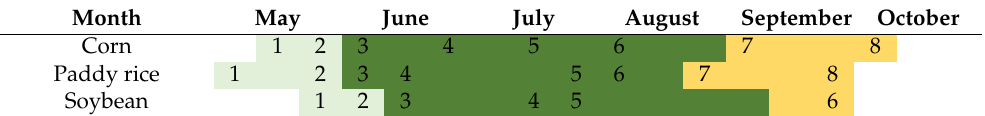
Table 1. The phenology of crops in Northeast